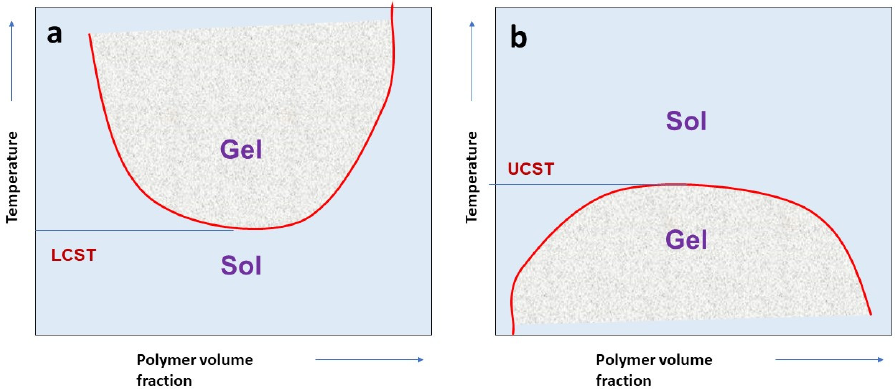
Figure 2. Sol-gel phase transition behavior of thermosensitive polymers ( a ) at lower critical solution temperature (LCST) and ( b ) at upper critical solution temperature (UCST) .